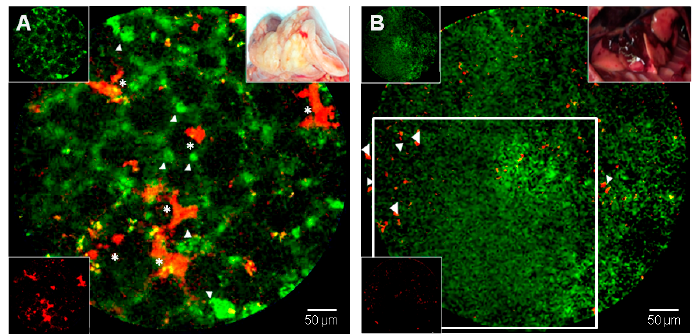
Figure 6. Two video captures exemplifying a dual-band (duplex) preclinical in vivo imaging of lung airspaces in different conditions (see Supplementary Materials). ( A ) Three-weeks after radiation-induced lung injury [75–80]. The rat was intravenously injected with fluorescein (FITC)-Dextran (green) and 1,1 ′ -Dioctadecyl-3,3,3 ′ ,3 ′ -Tetramethylindodicarbocyanine-DiD-labeled mesenchymal stromal cells (MSC, in red) seven days before imaging. Green fluorescent dye highlights acinar structures or concentrate in presumed phagocytic cells (white arrows), as well as several areas of grafted red MSC are detectable (white asterisks). ( B ) Two weeks after intratracheal instillation of bleomycin. The rat was intravenously injected with a matriptase (MAT) smart probe and TO-PRO-3, a carbocyanine monomer nucleic acid stain which can access a permeabilized nuclear membrane only in apoptotic cells. A hepatized lung airspace region is shown with loss of traditional acini and septation framework; diffuse MAT capitation/activation (green, open white square) and essentially sparse and peripheral cell nuclear visioning (red, white arrows). Overall, this area would have been defined as a “ground glass opacity” or a “consolidation at a radiological level, or as a ”diffuse alveolar damage” (DAD) at the histopathological level, and is further characterized by a diffuse MAT activation (both representative of inflammation and linked to damaged foci of fibrogenesis with surrounding cell apoptosis at an intra-vital molecular level) [69]. Cellvizio™ Dual Band (Mauna Kea Tech.). A macroscopic appearance of ( A ) and ( B ) in vivo lungs are displayed as both upper right inserts, and individual labeling are displayed in left-side inserts.